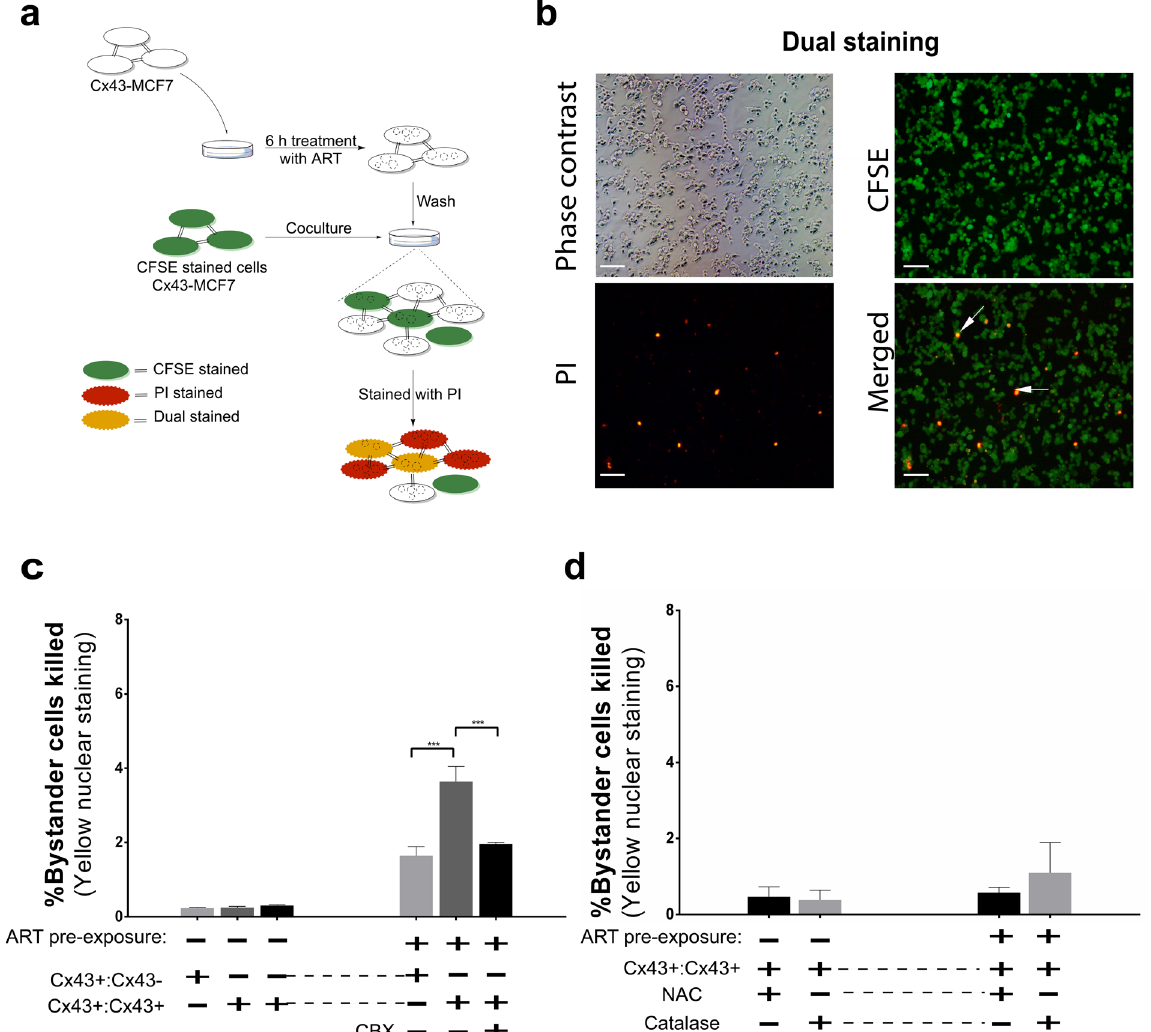
Figure 5. Induction of apoptosis in bystander cells after coculture with ART pre-treated cells. ( a ) Scheme of the experimental protocol used to delineate the bystander effect of ART. ( b ) After the onset of 48 h of coculture, the cells were stained with PI to examine the dead or membrane compromised cells. Nucleus of ART pre- treated dead cells appeared red while CFSE labelled membrane compromised cells showed yellow nucleus stain (arrow). Bar = 100 µ m. ( c,d ) Quantitation of red and yellow nuclei after 48 h of coculture in ART pre-treated Cx43-MCF7 cells in presence or absence of CBX are presented. NAC and catalase were also used to examine the involvement of ROS in mediating bystander cell toxicity. The percentage of PI-labelled yellow nucleus cells counted from multiple fields (n = 6) was